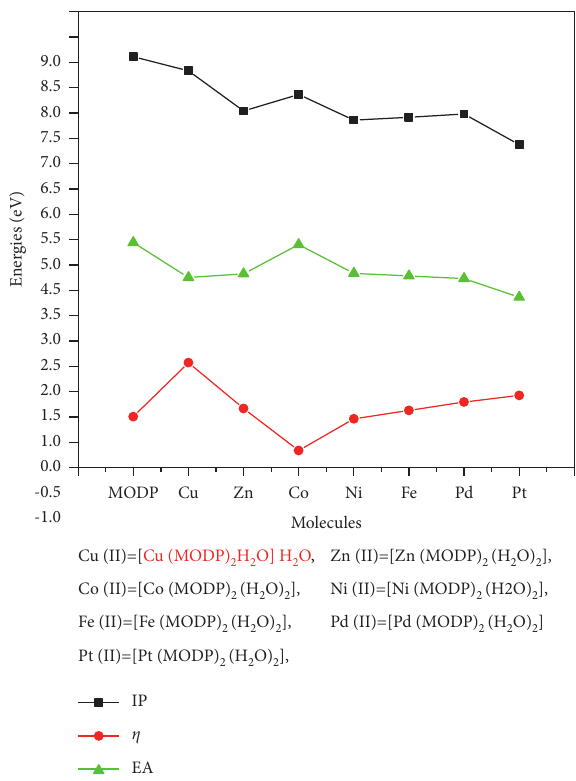
Figure 6: IP, EA energies, and η of the molecules studied at the PBE0-D3(BJ)/def2-TZVP level of